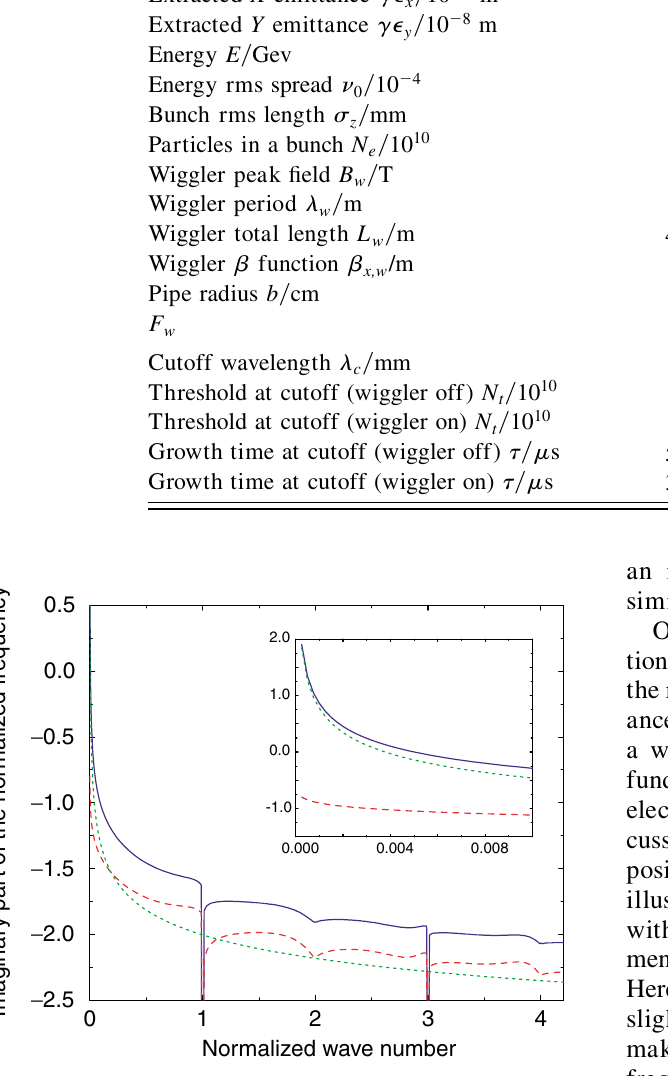
0 is the on-axis 0